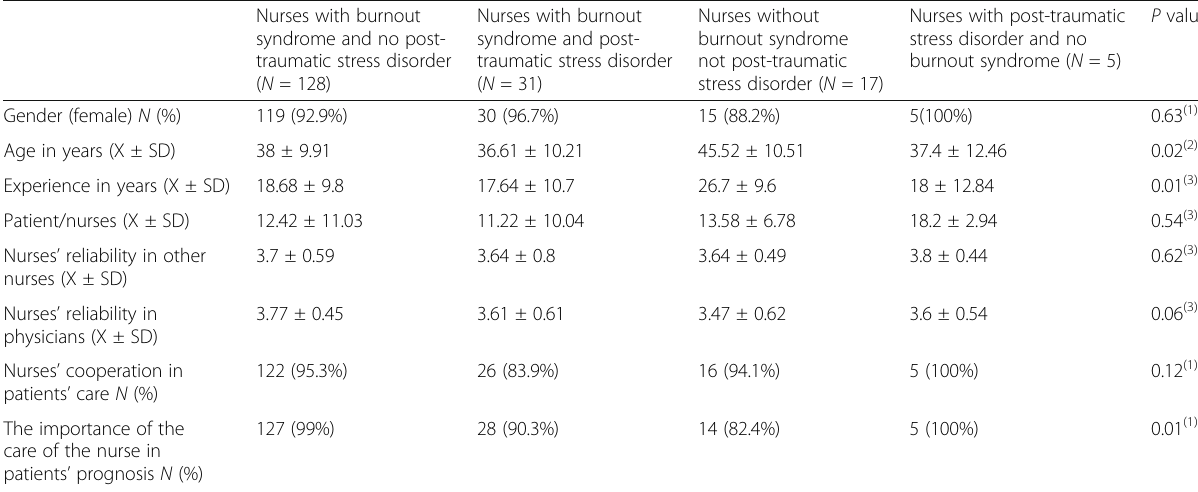
Table 2 Comparison between nurses diagnosed with/without burnout syndrome and/or post-traumatic stress disorder